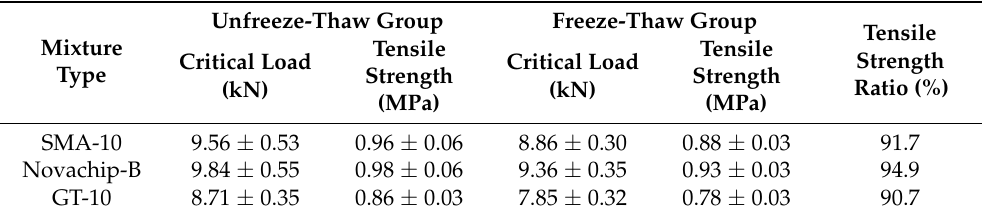
Figure 7. Results of Marshall stability and tensile strength. Table 4. Results of tensile strength